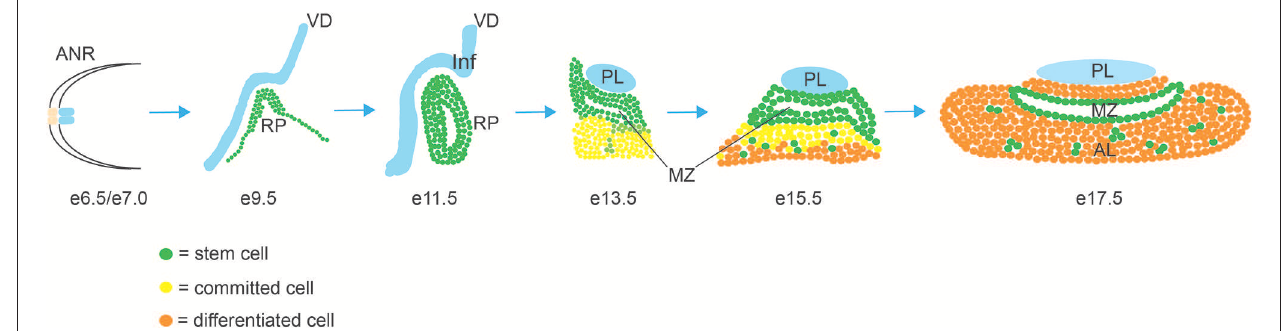
FIGURE 1 | Morphogenesis of the mouse pituitary gland. Abbreviations: AL, anterior lobe; ANR, anterior neural ridge; IL, intermediate lobe; Inf, infundibulum; MZ, marginal zone; PL, posterior lobe; RP, Rathke’s Pouch; VD, ventral